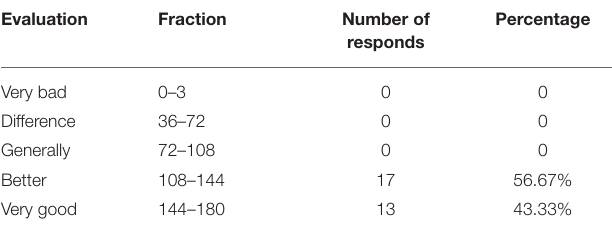
TABLE 4 | Statistics of the total score distribution of the course interest questionnaire.